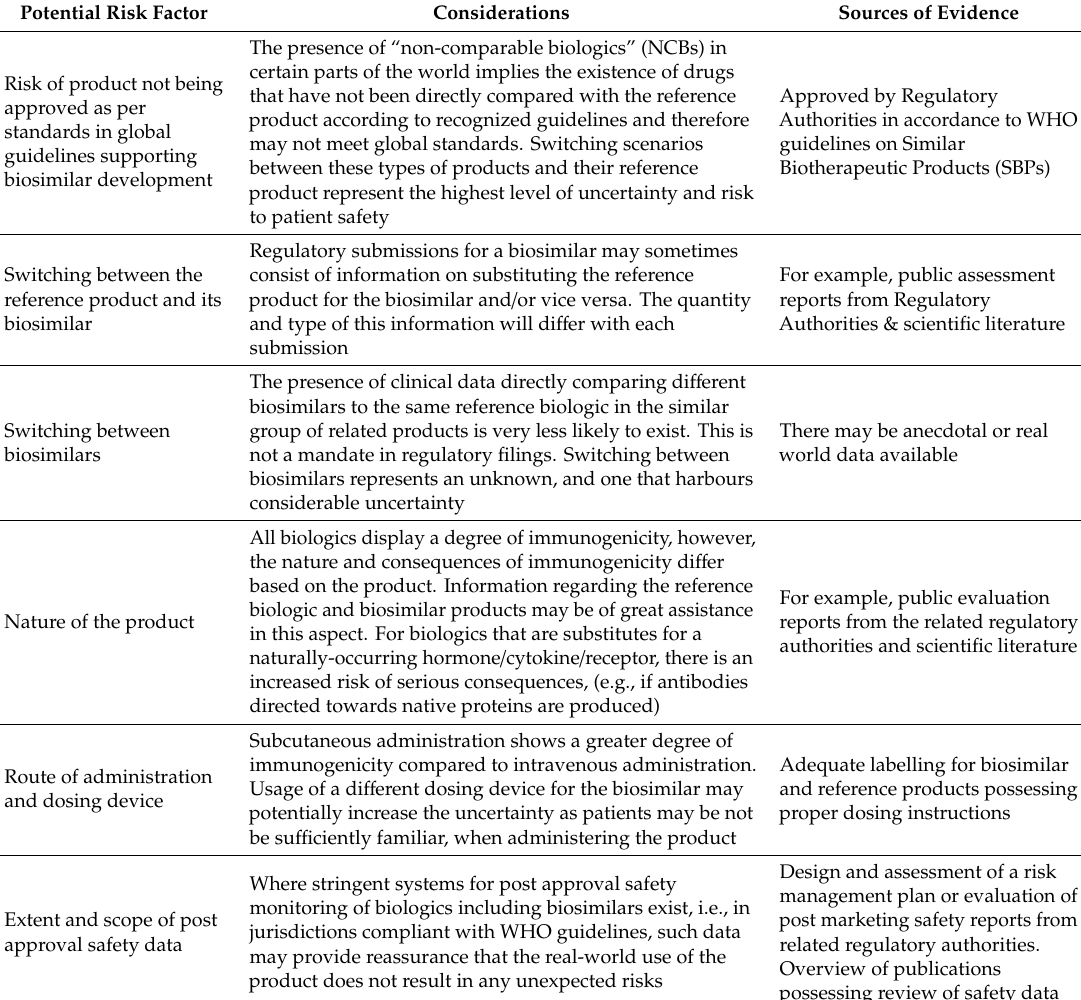
Table 6. Risks and Considerations in